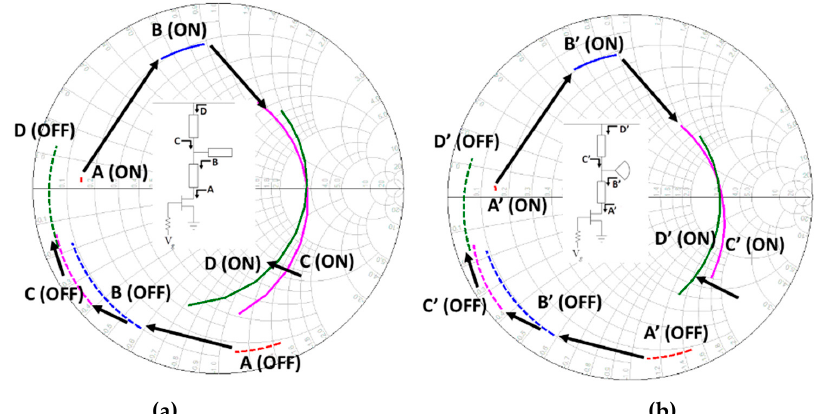
Figure 6. Trajectories of the impedance transform based on different topologies: ( a ) Conventional topology using open-stub element; ( b ) Proposed one using radial-stub element. (Dashed lines represent the impedance of OFF-state; Solid lines for the impedance of ON-state.).